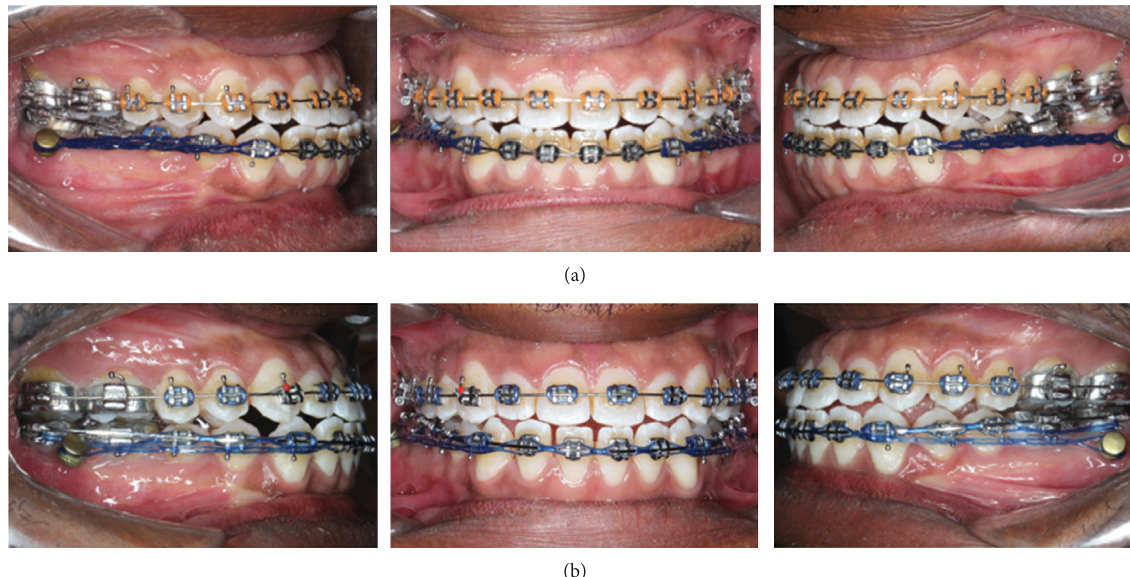
Figure 5: Progress intraoral photographs: (a) miniplates are placed on both sides and en masse distalization has just started; (b) the molars are overcorrected to end-on Class II molar